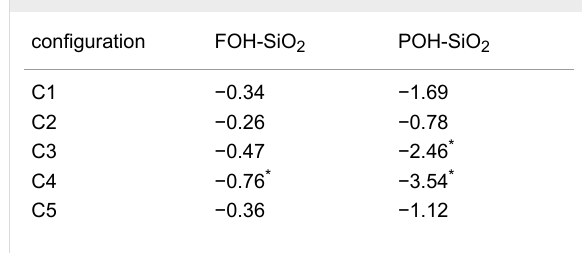
Table 1: Calculated adsorption energies (in eV) of Co 2 (CO) 8 on SiO 2 surfaces. Configurations marked with an asterisk change as a result of geometry optimization and are discussed in the